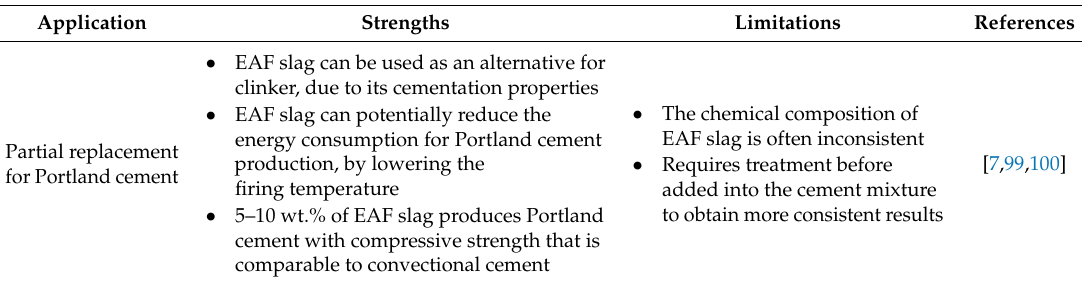
Table 8. Strengths and limitations of incorporating EAF slag in partial replacement for Portland